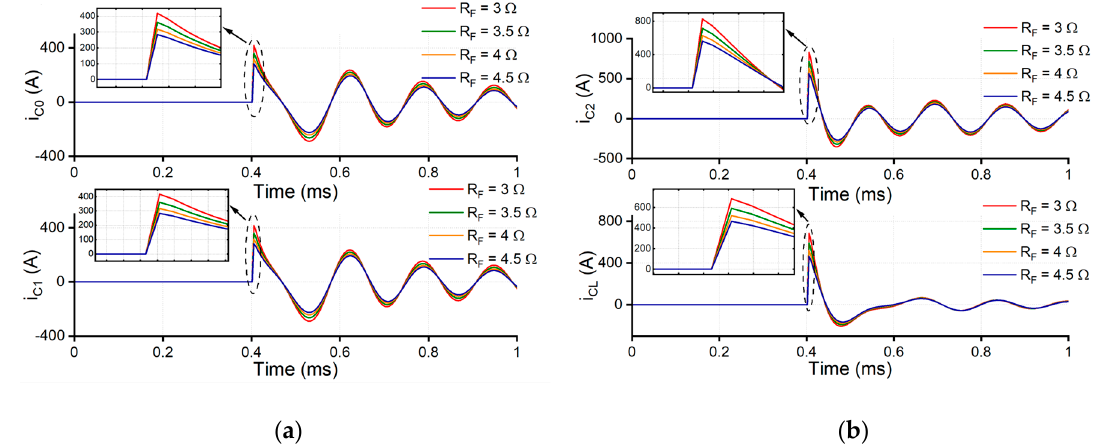
Figure 11. Example of transient current measurements under di ff erent HIF resistances, with C ZCB-Mul = 1.0. ( a ) Transient current through C 0 and C 1 . ( b ) Transient current through C 2 and C L